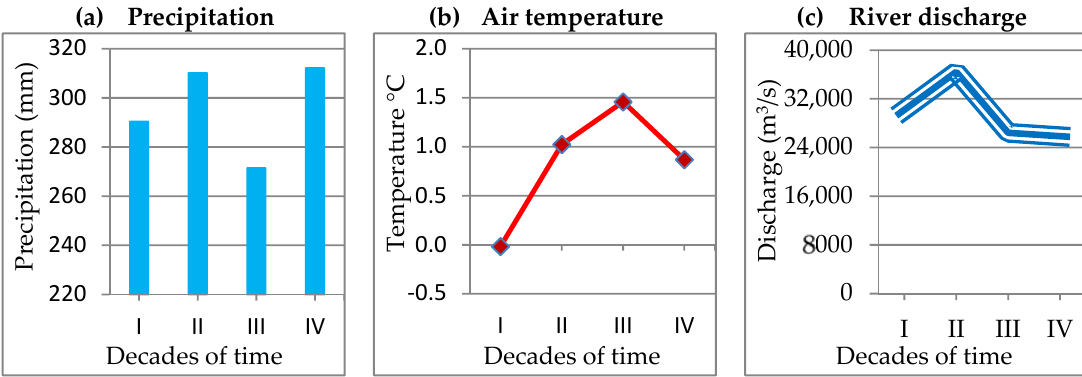
Figure 10. Decades changing of climate and river discharge.